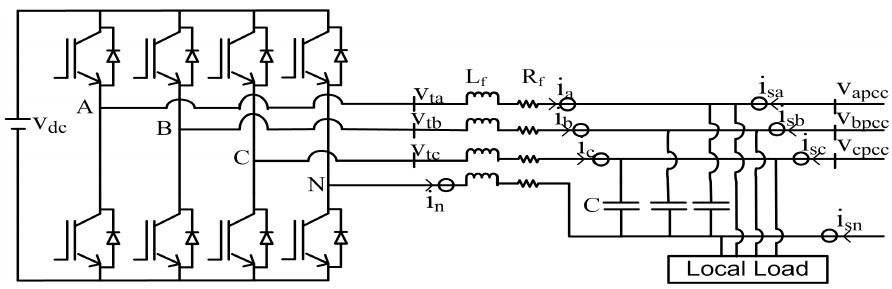
Figure 2. Schematic of voltage source converter (VSC) in distributed generations (DGs).